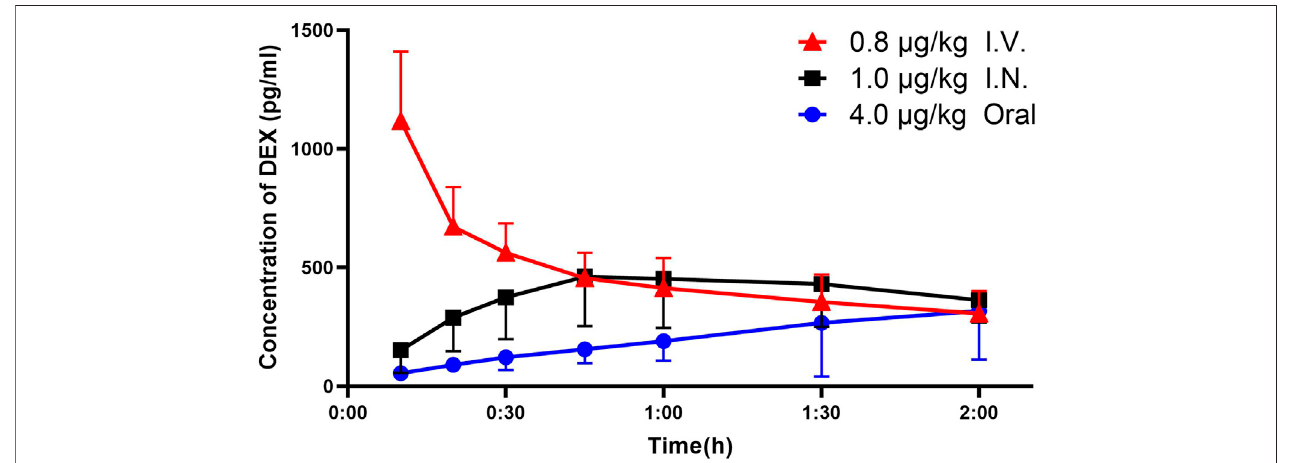
FIGURE2 | Plasma concentration – time curve and analysisof DEX.Plasma concentrationsofDEX (mean ± standard deviation) were higher in theIV and INgroups at 10, 20 30, 45 and 60 min after administration compared to the oral group and higher in the IV groups at 10, 20 and 30 min compared with the IN group. DEX = dexmedetomidine; I.V. = intravenous; I.N. = intranasal.